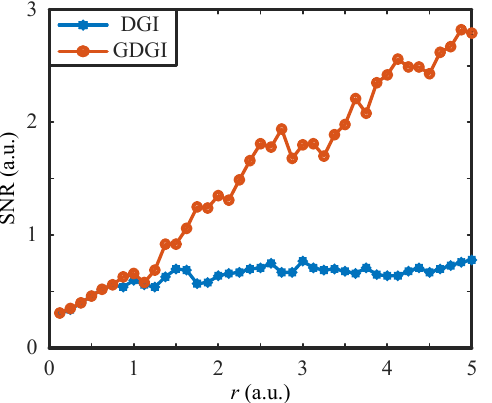
Figure 10. SNR values of the images reconstructed by the DGI and GDGI for the binary object “BIT” with different sampling rates r